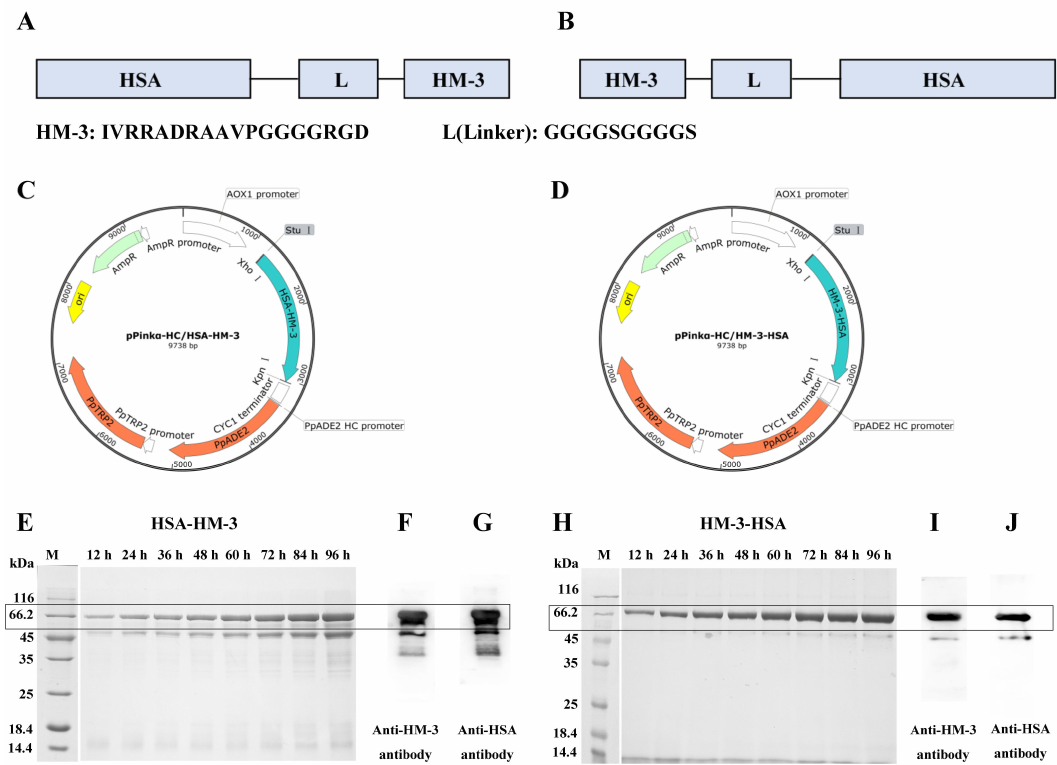
Figure 1. The expression of HM-3/HSA fusion proteins. ( A , C ) Design and construction of the pPink α -HC- HSA-HM-3 plasmid. ( B , D ) Design and construction of the pPink α -HC- HM-3 - HSA plasmid. ( E ) SDS-PAGE analysis of HSA-HM-3 expressed in yeast. ( F ) Western blot analysis of HSA-HM-3 by the monoclonal antibody against HM-3. ( G ) Western blot analysis of HSA-HM-3 by the polyclonal antibody against HSA. ( H ) SDS-PAGE analysis of HM-3-HSA expressed in yeast. ( I ) Western blot analysis of HM-3-HSA by the monoclonal antibody against HM-3. ( J ) Western blot analysis of HM-3-HSA by the polyclonal antibody against